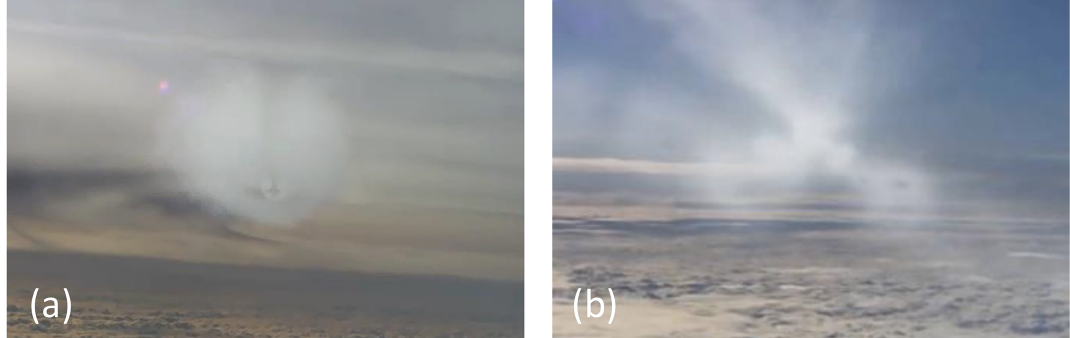
Figure 4. Contrails of the A320 recorded by the DC-8 forward camera on two different days and for different ambient conditions during ECLIF II/NDMAX. Source: National Suborbital Research Center. ( a ) Contrail unaffected by sublimation. ( b ) Contrail affected by sublima- tion with a secondary wake forming above the descending contrail